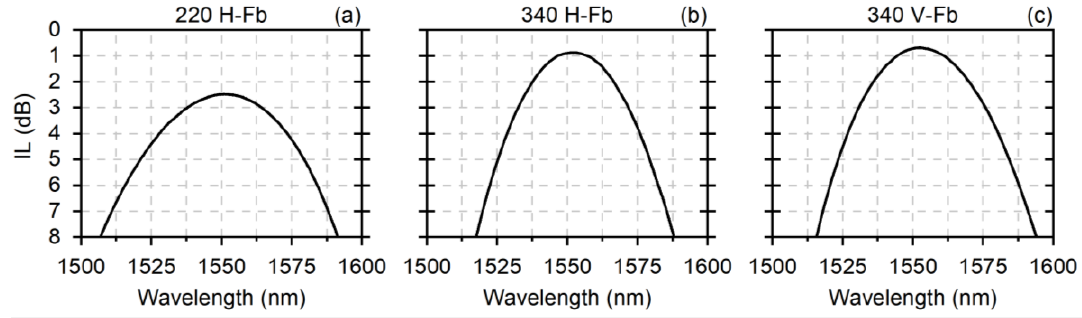
Figure 10. Insertion loss in dB for the apodized focusing grating couplers: ( a ) 220 nm platform optimized for the H-Fb scheme, ( b ) 340 nm platform optimized for the H-Fb scheme, and ( c ) 340 nm platform optimized for the V-Fb scheme.